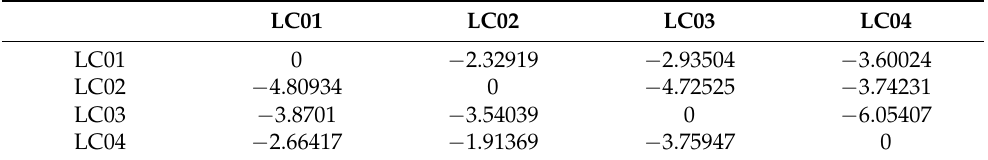
Table 4. Sum of single criterion dominances [ δ